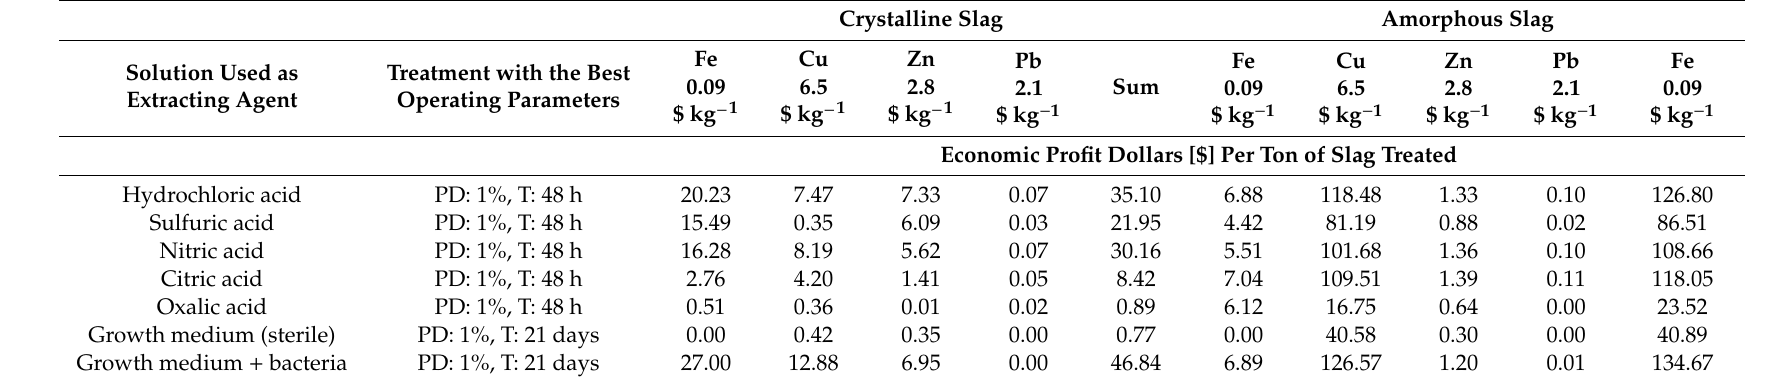
Table 3. Estimated economic potential of chemical and biological treatment of